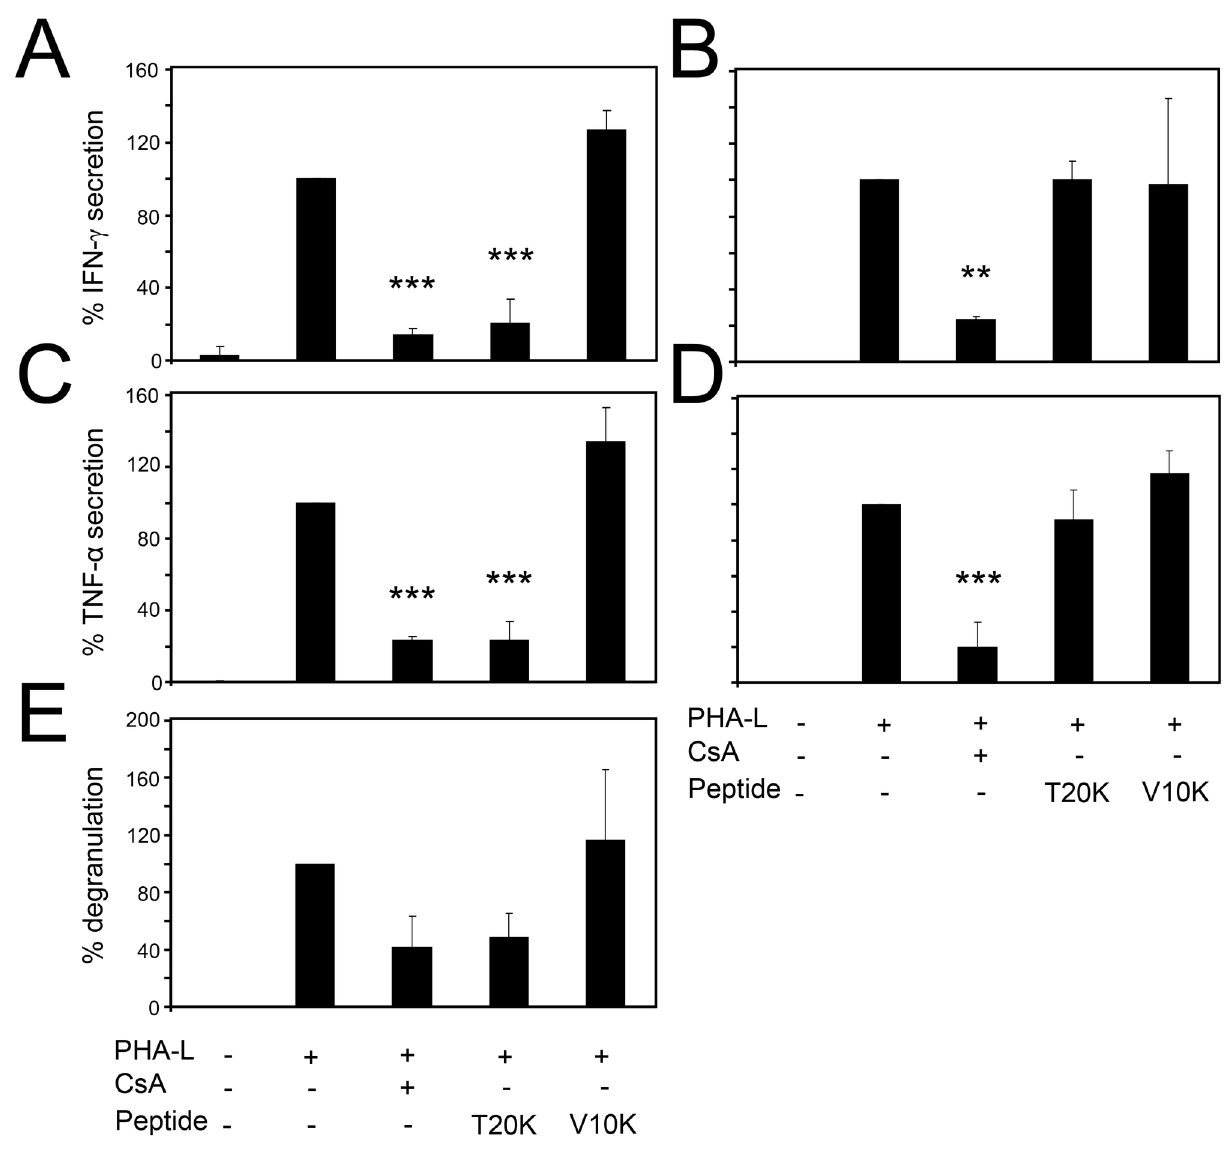
Figure 5. Influence of cyclotide mutants on effector function of primary activated human lymphocytes. Purified lymphocytes were preincubated with CsA or cyclotides (4 µM each), then stimulated with PHA-L (10 µg/mL) and exposed to a re- stimulation impulse with PMA and ionomycin for 6 h before analysis of effector functions, expressed as amounts of IFN-γ (24 h: A ; 36 h: B ), TNF-α (24 h: C ; 36 h: D ) or degranulation capacity ( E ). The amount of IFN-γ and TNF-α was measured in the supernatant of cultured cells using an ELISA-based method for early time points, or intracellular cytokine detection flow cytometric analysis for late time points. The degranulation capacity was detected by using classical CD107a assay. Data of three independent experiments were presented as mean ± SD. The asterisks represent significant differences of treated cells in comparison to ctrl or PHA-L stimulated cells alone (* P <0.05, ** P <0.01, *** P <0.001). doi: 10.1371/journal.pone.0068016.g005 After determining the influence of cyclotide treatment on the vesicle membranes fuse with the membranes of activated T- effector function of T-lymphocytes, it was of interest to lymphocytes and therefore LAMP-1 can be used as a marker determine cyclotide-induced changes on the degranulation protein for the cytotoxic activity of these cells. After 36 h, 42% ± activity. Activation of T-lymphocytes leads to a release of 21 of the CsA and 49% ± 17 of the [T20K] kalata B1-treated cytolytic granules that contain lysosomal-associated membrane cells contained the degranulation marker LAMP-1 as compared protein 1 (CD107; LAMP-1). During degranulation, the granule to the control (Figure 5E), which demonstrated that either